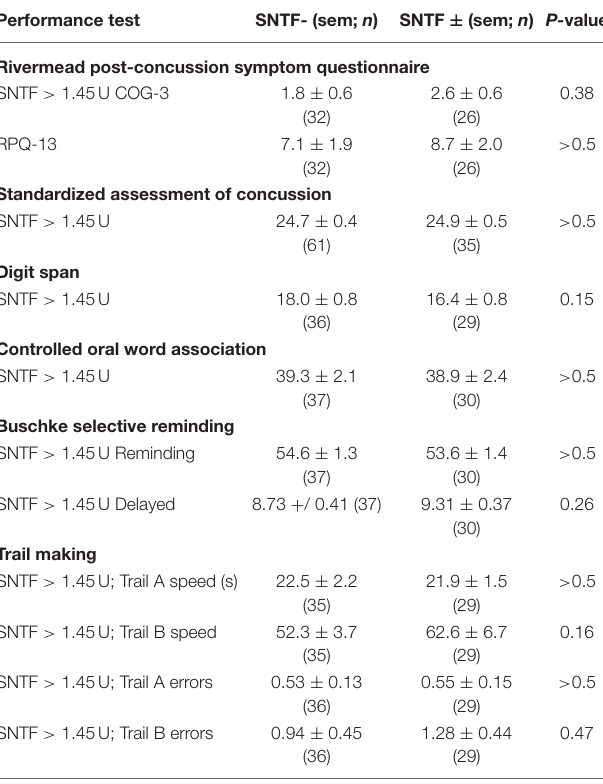
problems via the COG-3 sub-score, or emotional and somatic symptoms via the RPQ-13 sub-score, did not reveal self-reported symptomatic differences that associated with the day of injury serum SNTF